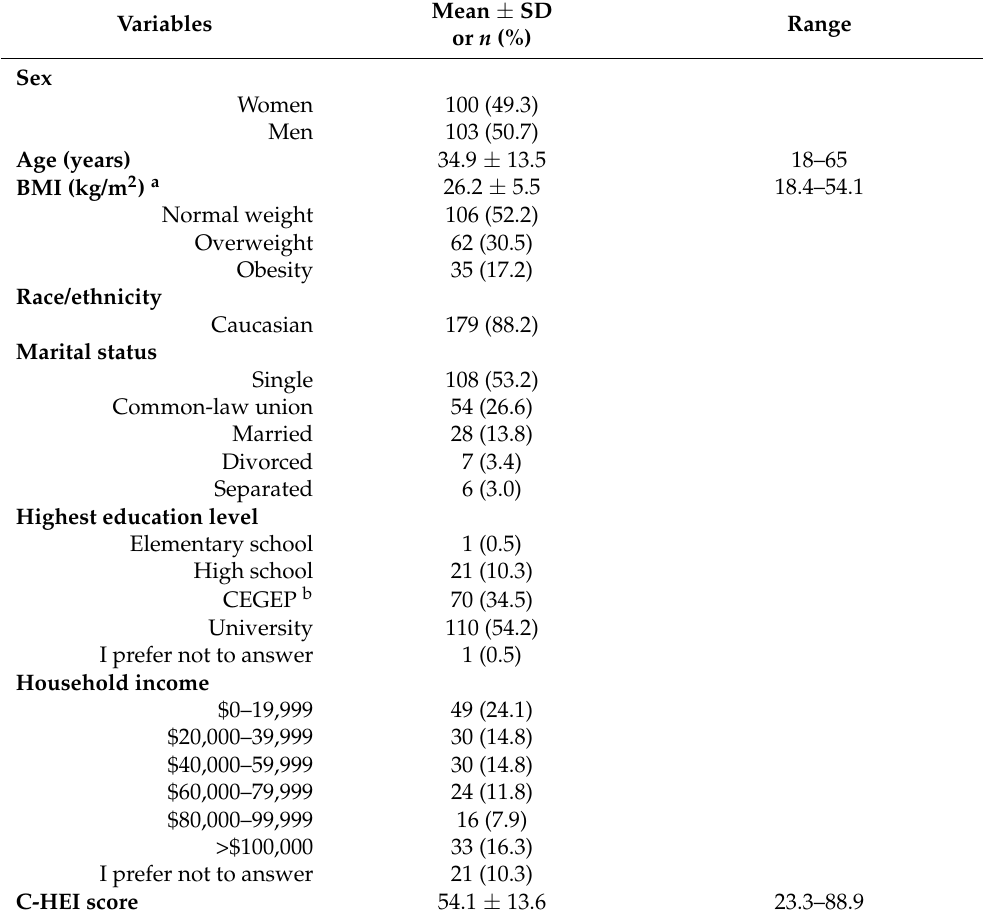
Table 2. Participants’